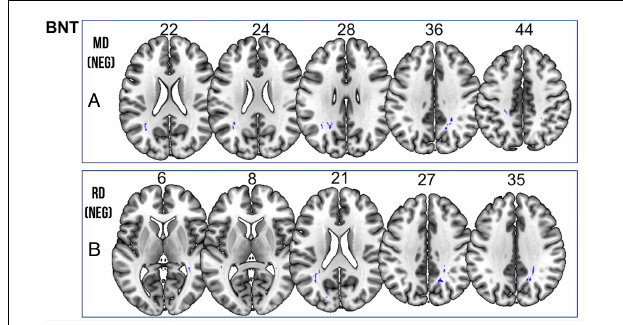
FIGURE 5 | Significant correlations between BNT scores and (A) MD and (B) RD values ( p < 0.05, cluster-wise FDR corrected for multiple comparisons). Pictures are in neurological convention with left side in the figure corresponding to the left side of the brain.